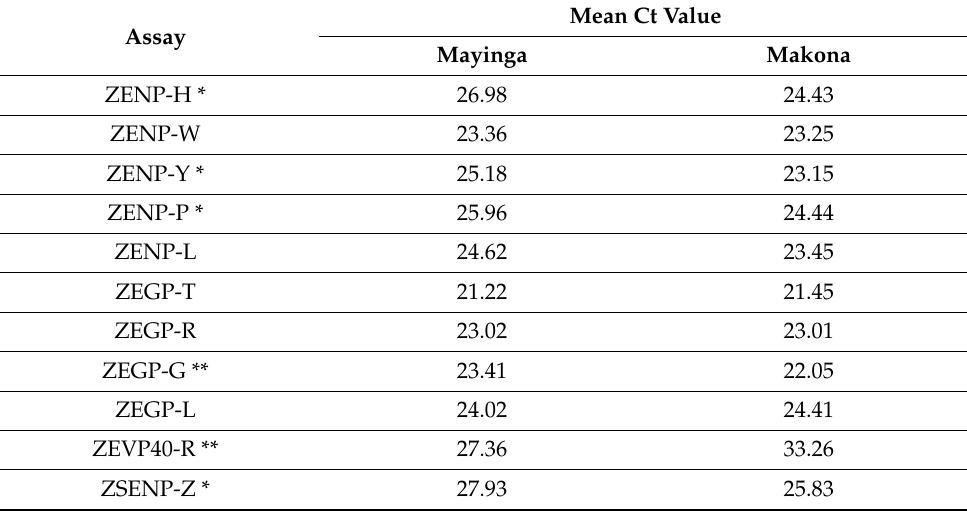
Figure 2. Specificity of ZENP-H, ZENP-Y, ZSENP-Z and ZEVO40-R assays for the EBOV Mayinga variant and the Makona variant. The specificity of ebolavirus species-specific real-time RT-PCR assays was examined using viral RNA extracted from the supernatant of cells infected with the EBOV-Mayinga variant and the Makona variant. Outside these assays, there was no difference in assay specificity between the two variants. Table 6. Specificity of real-time one-step RT-PCR assays specific for the Makona variant. Viral RNA extracted from the supernatant of cells infected with the EBOV-Mayinga variants and the Makona variant was used and the Ct values of these two variants from each assay are shown. *, difference between the Mayinga variant and the Makona variant ( p < 0.05); **, significant difference between the Mayinga variant and the Makona variant ( p <